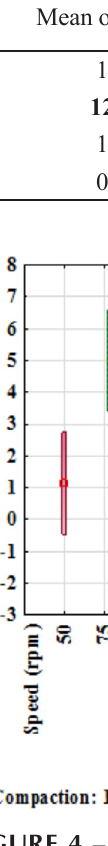
FIGURE 4 – Mean values of amlodipine besylate IDR (mg.cm -2 .min -1 ). Error bars indicate the standard deviation of the